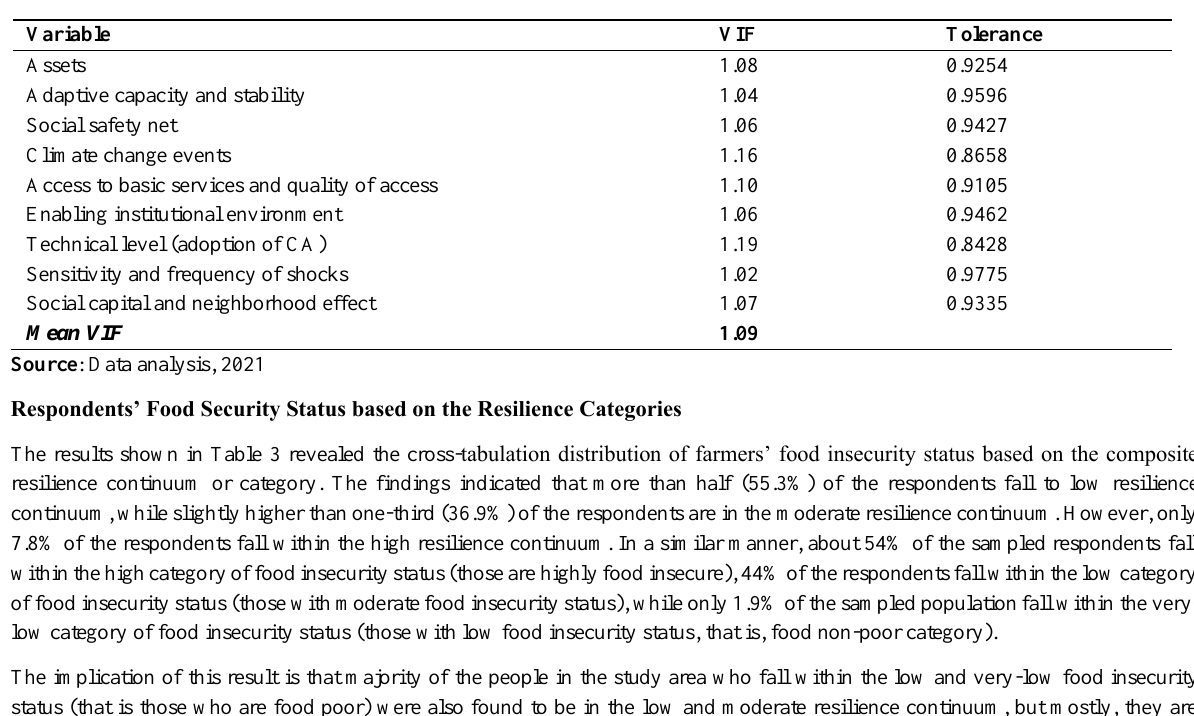
Table 2b: Collinearity Diagnostics